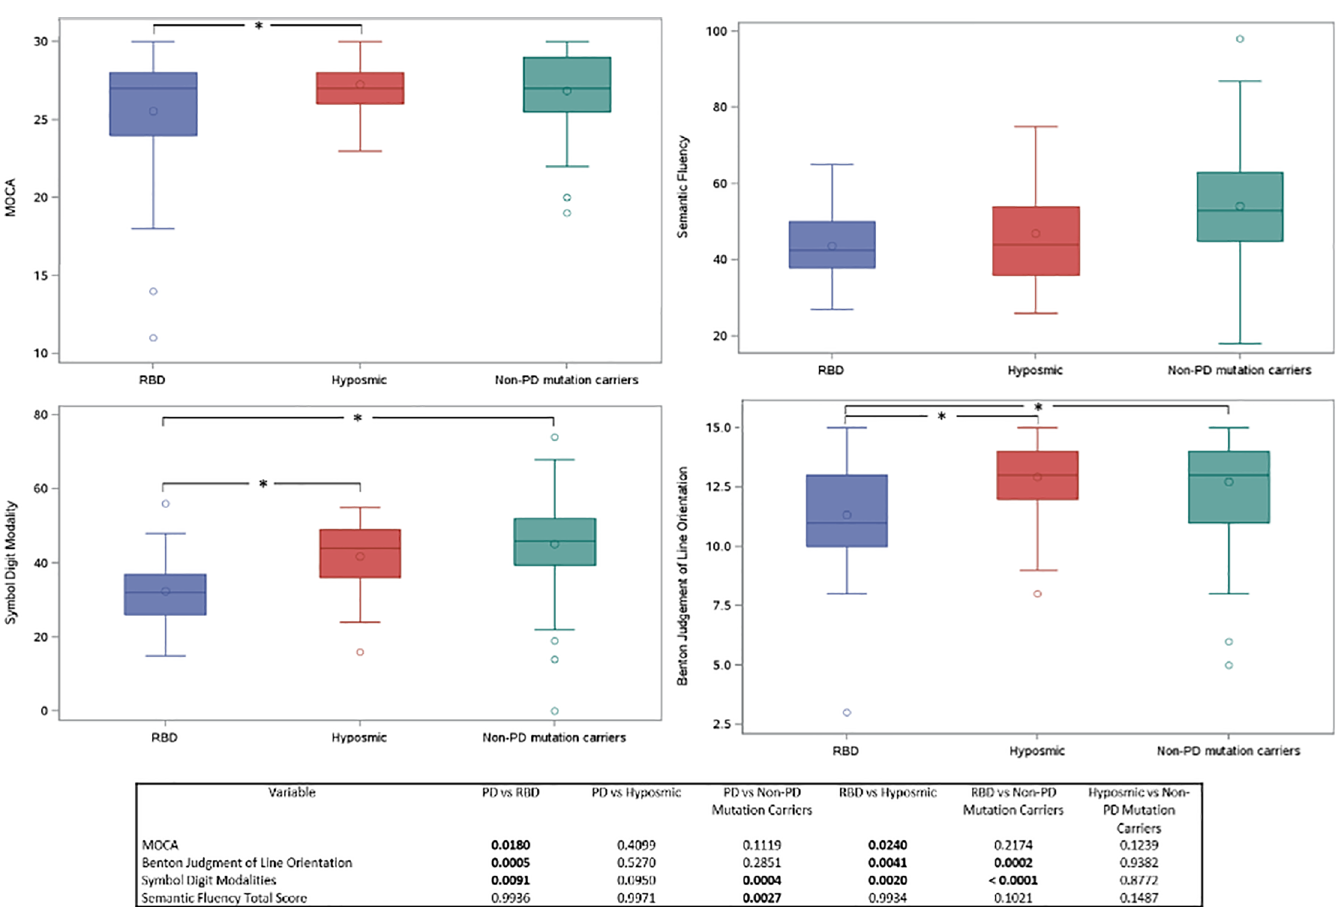
Fig 1. Graphical comparison of select neuropsychological test battery scores in the 3 at-risk groups. The scores for MoCA, semantic fluency, Symbol Digit Modalities Test (SDMT), and Benton Judgment of Line Orientation are shown for the 3 at-risk groups. Asterisks indicate significant difference in pairwise comparisons between